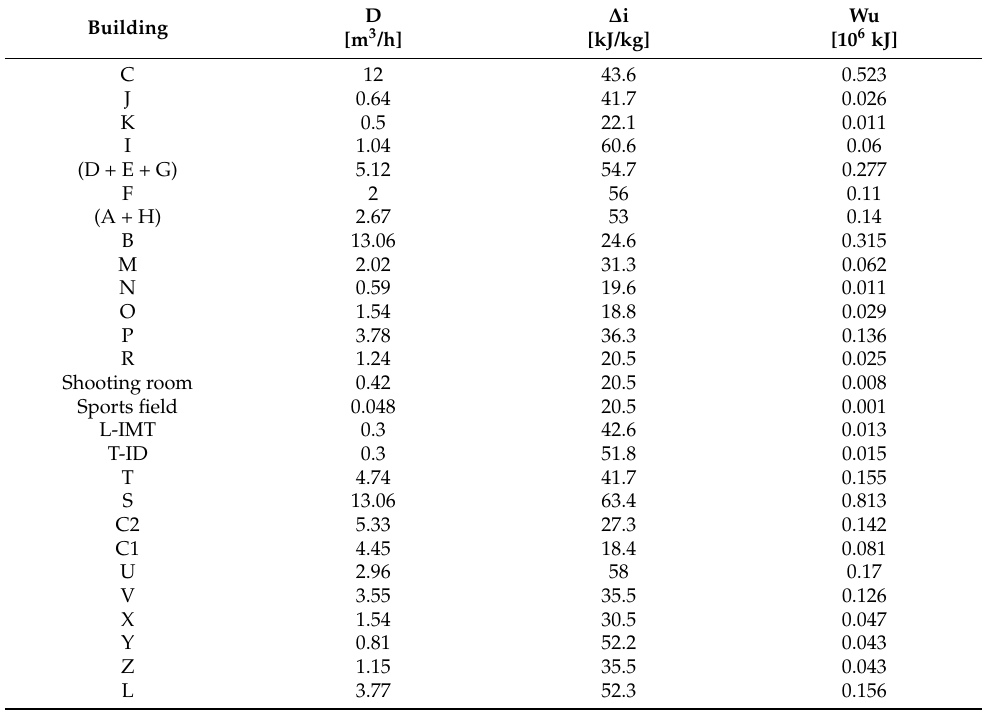
Table 8. Hourly values of useful energy components in 20–22 January